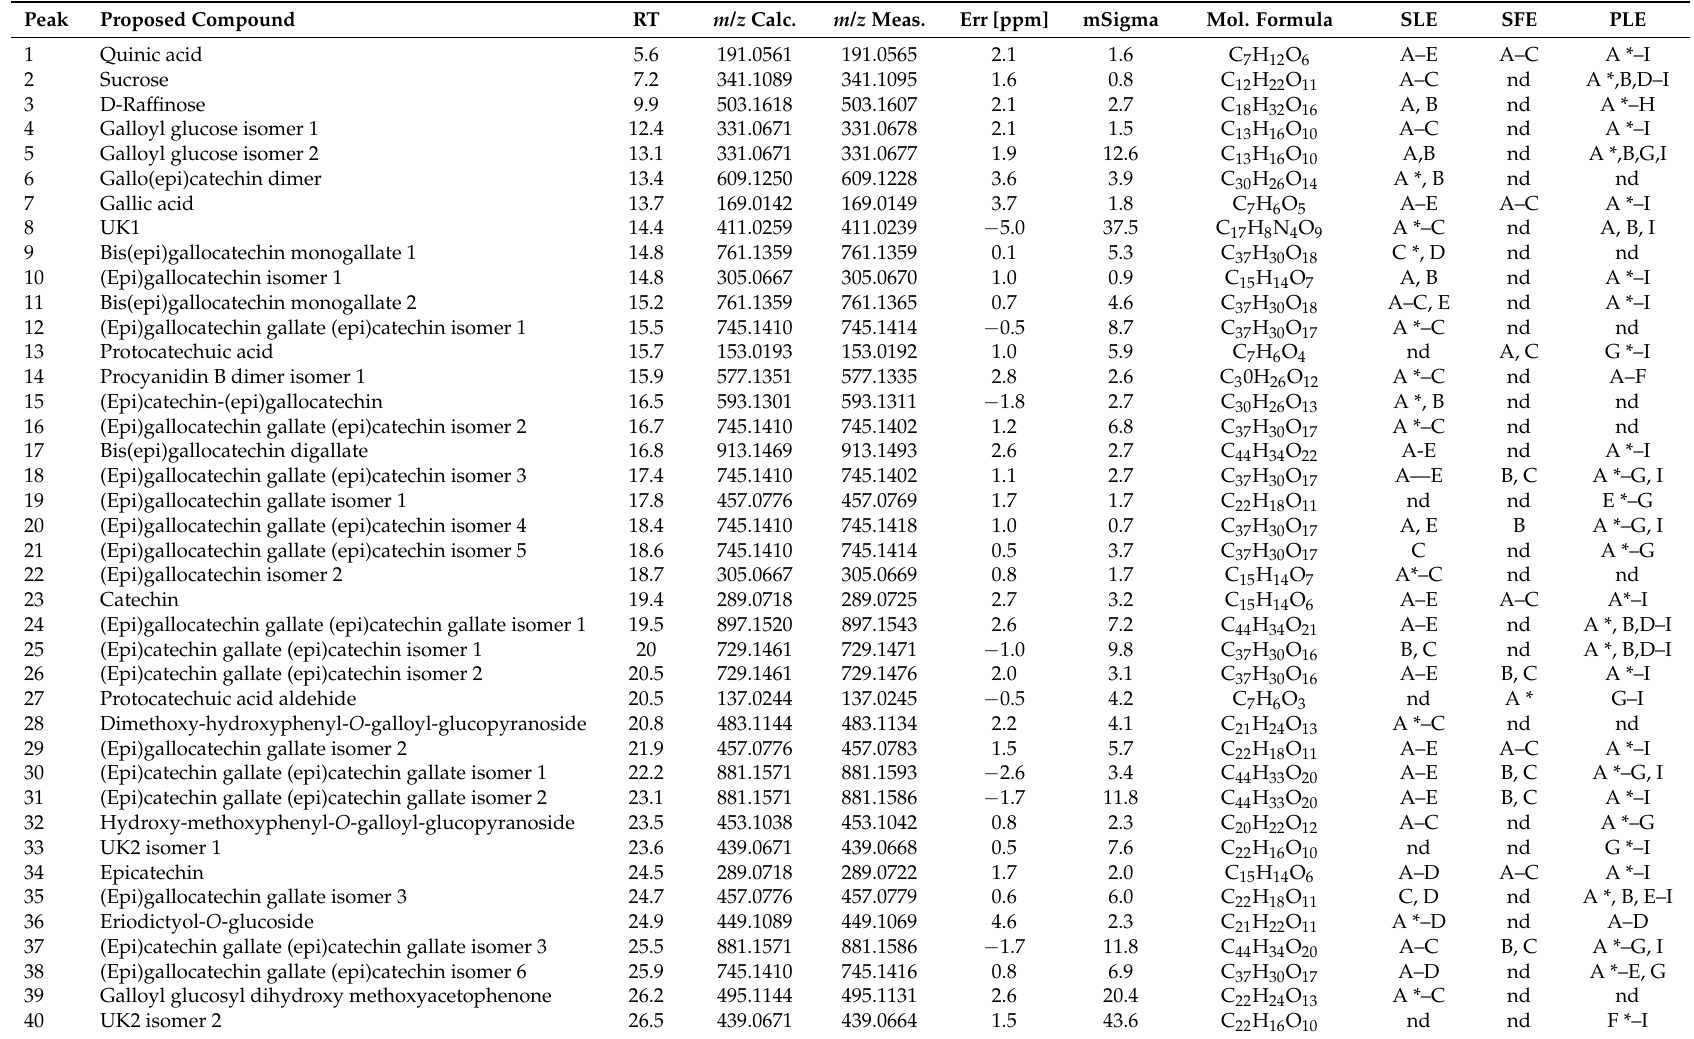
Table 1. Identified compounds in the S. birrea extracts by